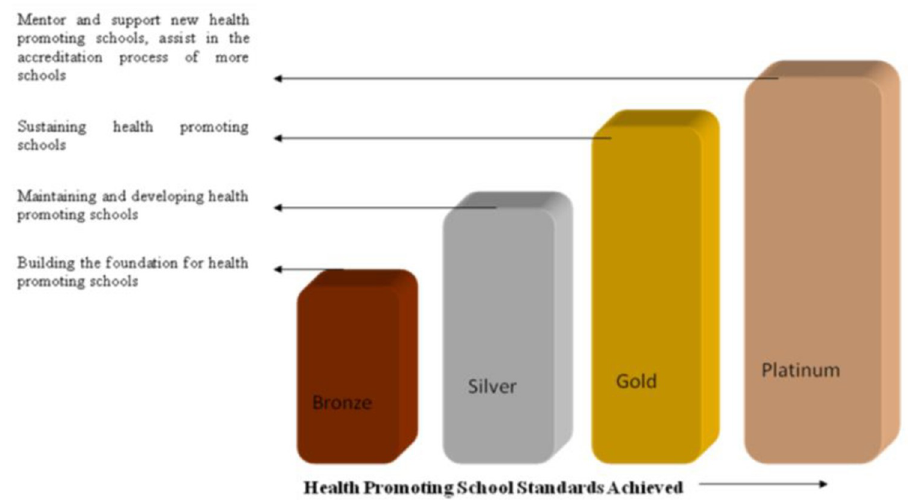
Fig 1. Health promoting schools accreditation